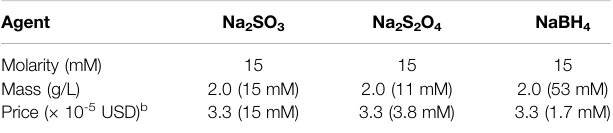
TABLE 3 | Scheme for comparison of loadings of reducing agents(sodium sul fi te, sodium dithionite, and sodium borohydride) based on molarity, mass, and cost (using 15 mM Na 2 SO 3 as the reference case). a